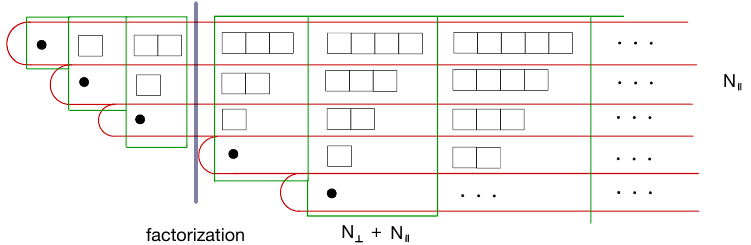
and modules, D l V (cid:1) n